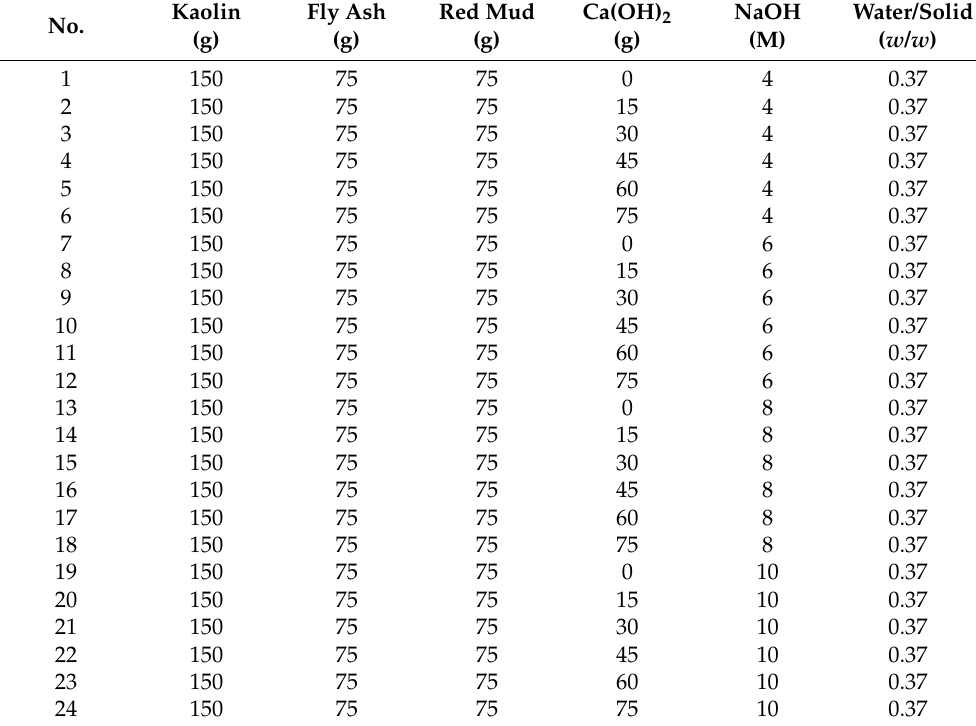
Table 2. Mixing ratios of raw materials for geopolymer